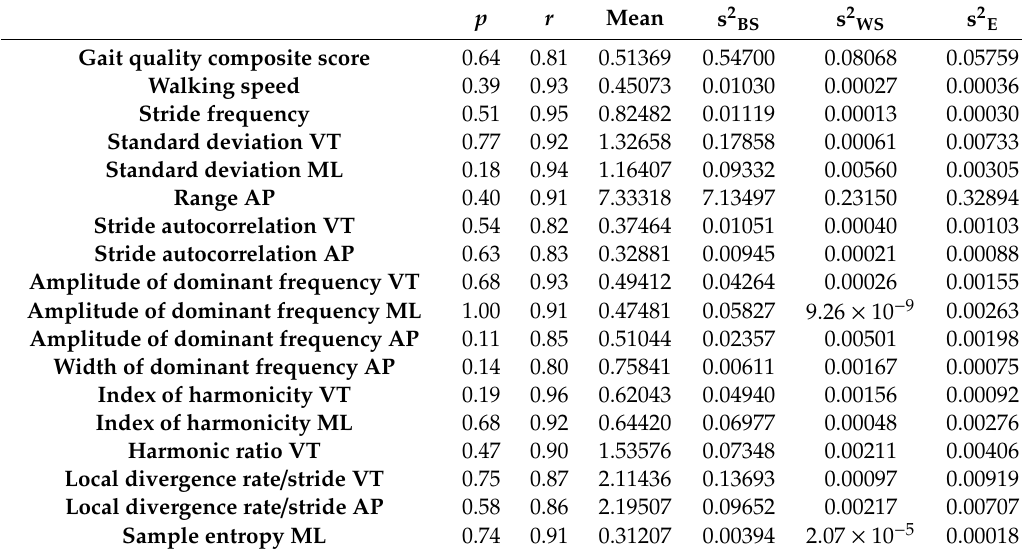
Figure 1. Agreement between the gait quality composite scores of the first and second week. Table 1. Agreement between weeks and estimated variance components for gait characteristics associated with prospective falls in [10].